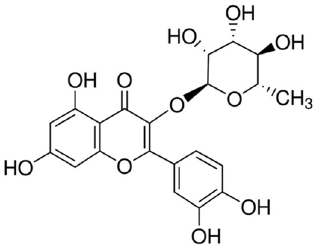
Figure 1. Chemical structure of quercitrin.